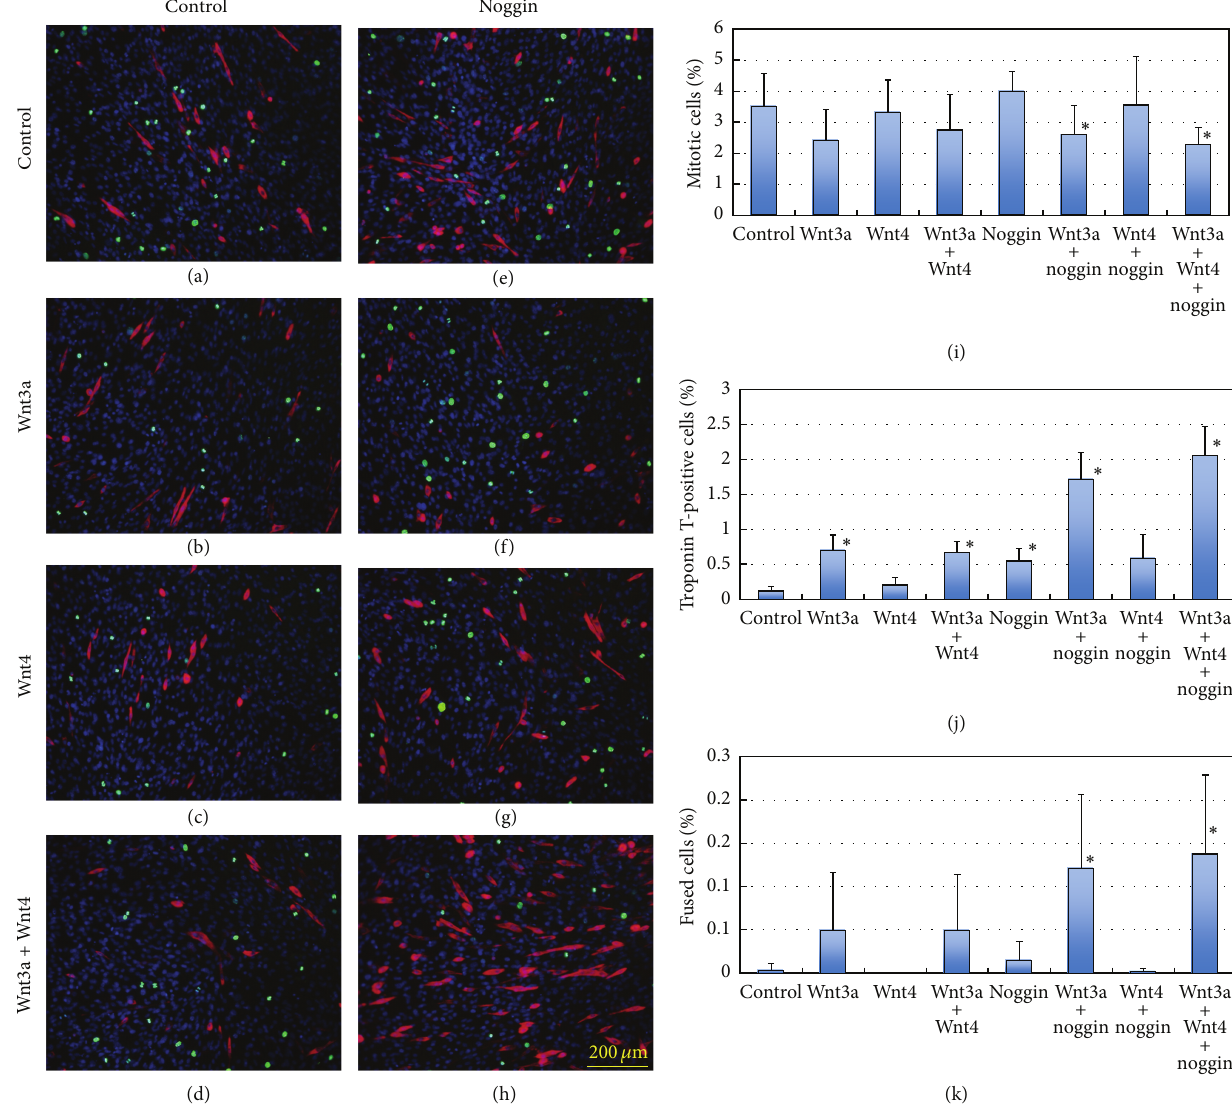
Figure 6: Effect of noggin on troponin T expression with or without Wnt3a and Wnt4. (a–h) The recombinant proteins were added as shown in Figure 3 with final concentrations of 125 ng/mL Wnt3a, 250 ng/mL Wnt4, and 50 ng/mL noggin, alone or in combination as shown in the figure. Immunohistochemical staining and cell counting were carried out as described in Figure 3. Addition of noggin elevated troponin T expression in the presence or absence of Wnt3a and/or Wnt4. (a) Control; (b) Wnt3a; (c) Wnt4; (d) Wnt3a + Wnt4; (e) noggin; (f) Wnt3a + noggin; (g) Wnt4 + noggin; (h) Wnt3a + Wnt4 + noggin. (i–k) The ratios of phosphohistone H3 (i) and troponin T-positive cells (j) to the total cell number were counted. Multinuclear cells expressing troponin T (k) were also estimated to determine the ratio of fused cells to the total cell number. Mean + SD ( 𝑛 = 6 ), ∗ 𝑃 < 0.01 versus control with Student’s 𝑡